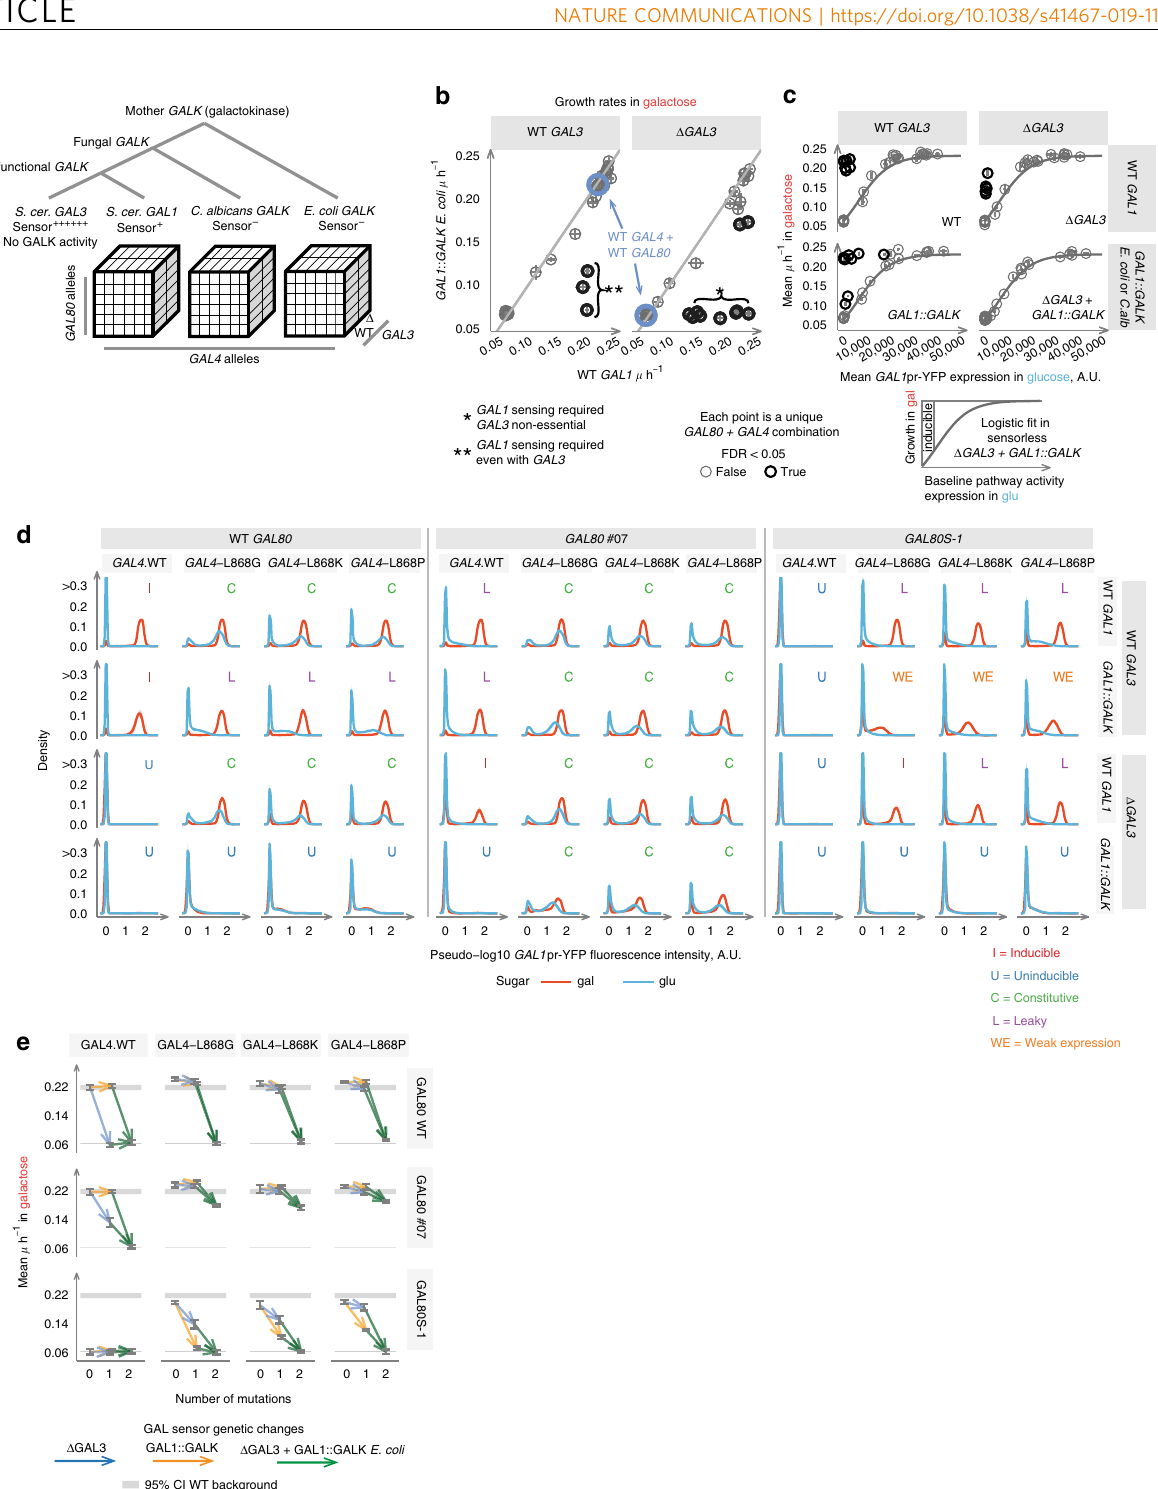
The molecular mechanism underlying the GAL4C + GAL80S-1 double-mutant phenotype is intriguing. The GAL pathway is tightly repressed in glucose for GAL4C + GAL80S-1 backgrounds, suggesting that GAL80S-1 associates more tightly than WT GAL80 to GAL4C variants. Similarly, the dominant-repressive nature of the GAL80S-1 mutant is suppressed in the GAL4C backgrounds, allowing high expression in galactose. This implies that GAL80S-1 must not only bind less ef fi ciently to Gal4Cp, but